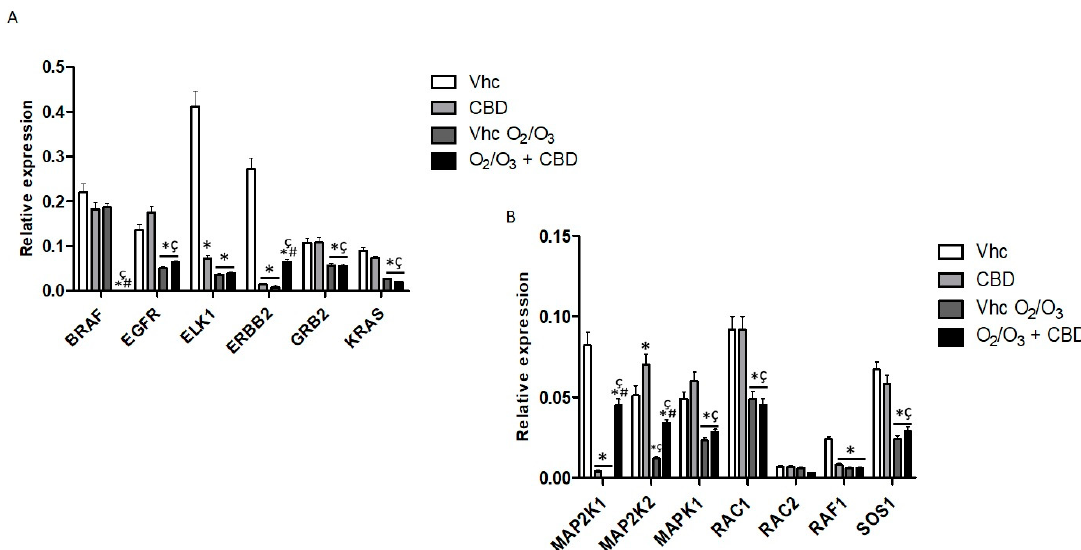
Figure 11. Modulation of Ras pathways in PANC-1 cell line. ( A ) BRAF , EGFR , ELK1 , ERBB2 , GRB2 , and KRAS mRNA expression and ( B ) MAP2K1 , MAP2K2 , MAPK1 , RAC1 , RAC2 , RAF1 , and SOS1 mRNA expression was evaluated by qRT-PCR in the PANC-1 cell line, treated with CBD in the presence and absence of O 2 /O 3 . Target mRNA levels were normalized for GAPDH expression. Data are expressed as fold mean ± SE. * p < 0.05 vs. Vhc, #, * p < 0.05 vs. Vhc O 2 /O 3 , Ç p < 0.05 vs. CBD.